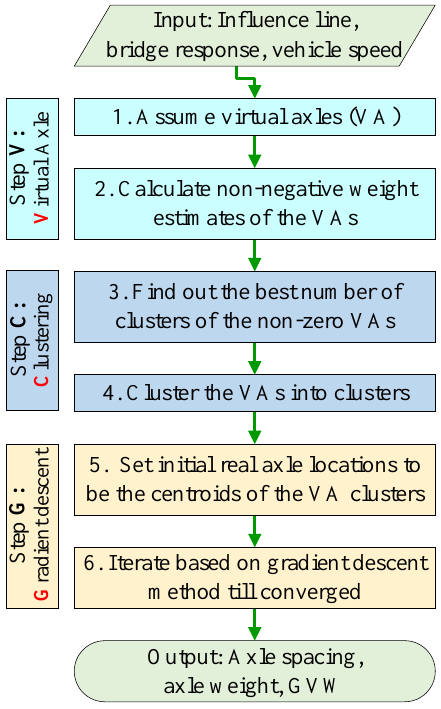
Figure 1. Frame of the VCG method.